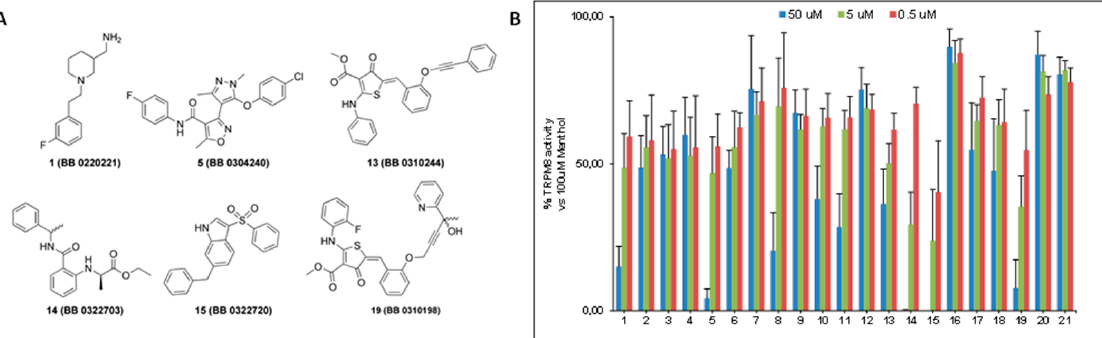
Figure 1. ( A ) Molecular structures of the most active compounds as TRPM8 blockers in Calcium fluorometric assays. In brackets are the original library codes ( B ) Bar-graph reporting the blocking activity of the 21 compounds arising from the virtual screening protocol against TRPM8 menthol- evoked currents. Table 2. IC 50s and efficacy for the selected compounds. Results are given as mean ± SD of at least three independent